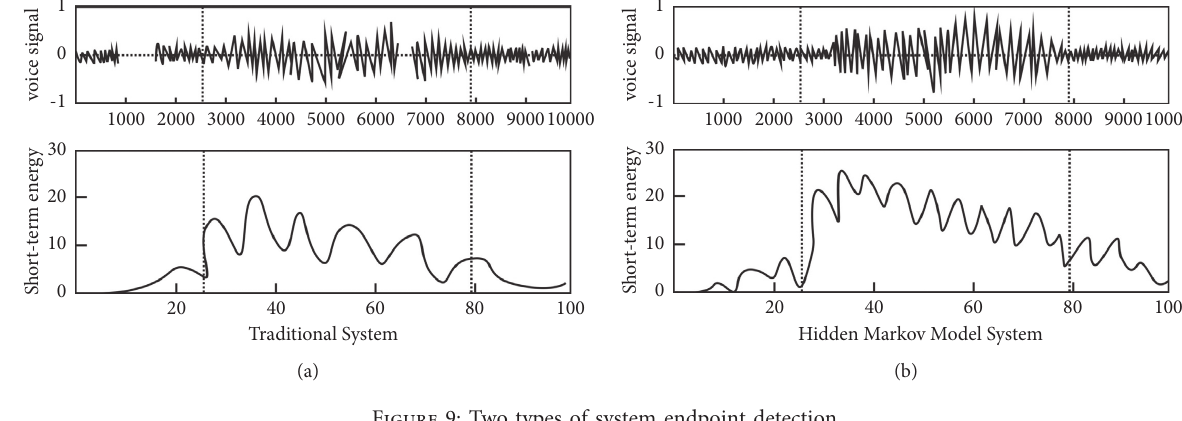
Figure 9: Two types of system endpoint detection.